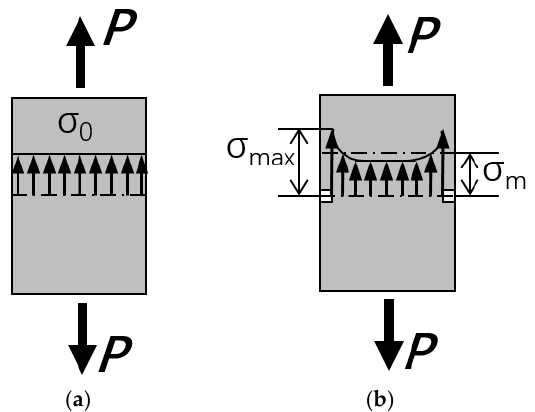
Figure 9. Schematic diagrams of stress distribution: ( a ) non stress concentration; ( b ) stress concentration.